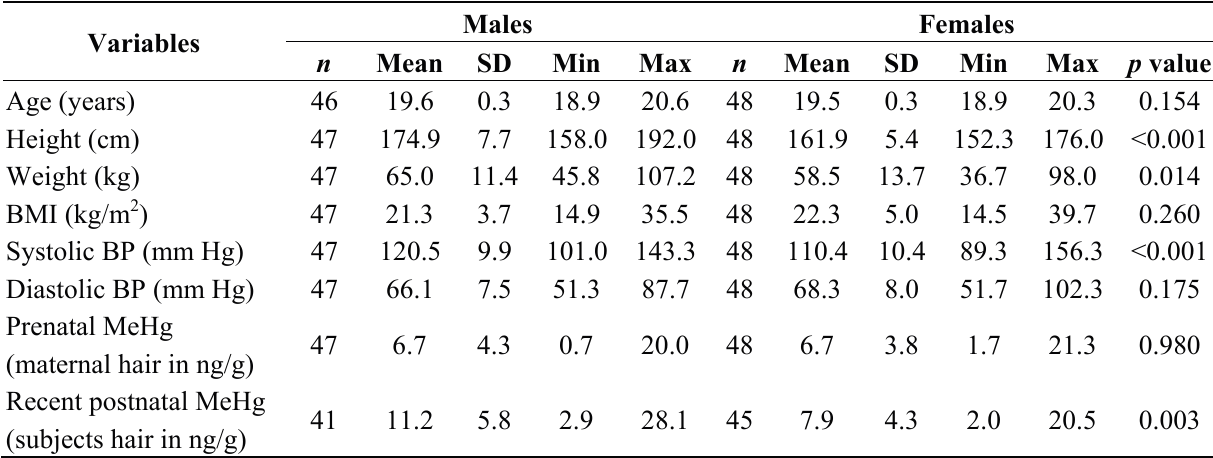
Table 1. Baseline characteristics of